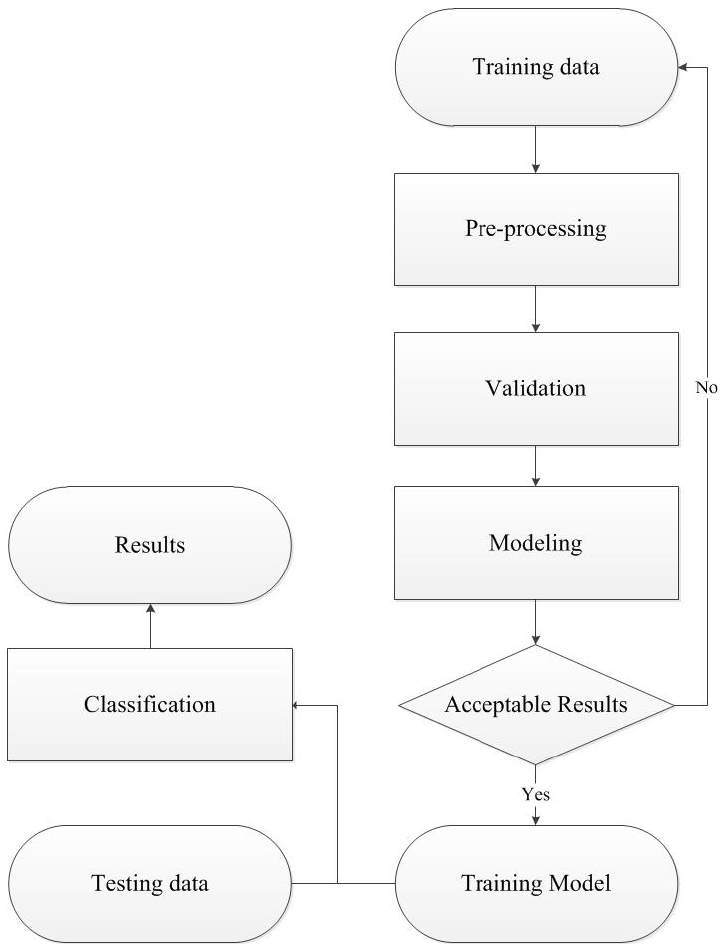
Figure 9. A pattern recognition framework for classifying organic and non-organic apple data.